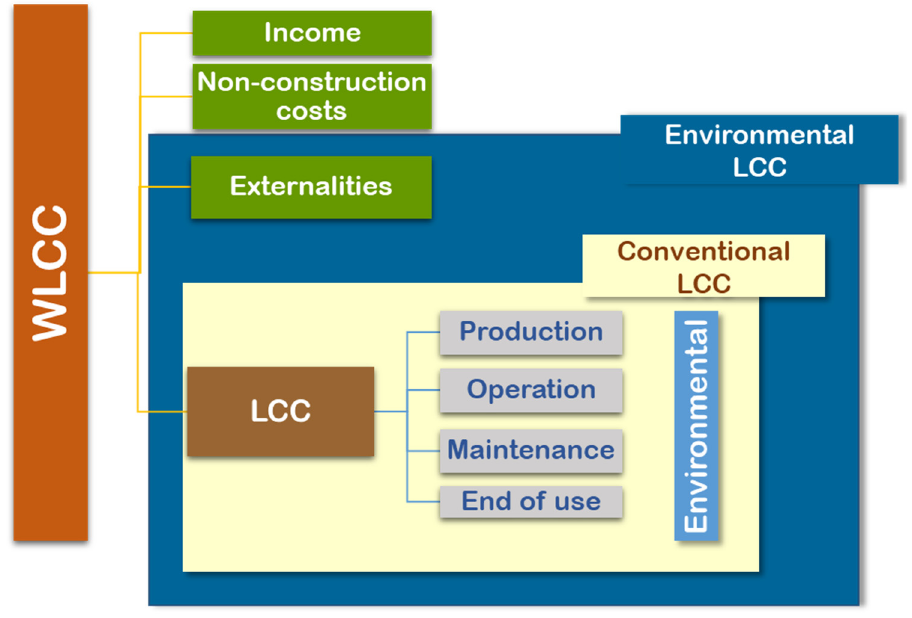
Figure 2. WLCC and LCC elements based on ISO 15686:5; 2017 (source: our elaboration).